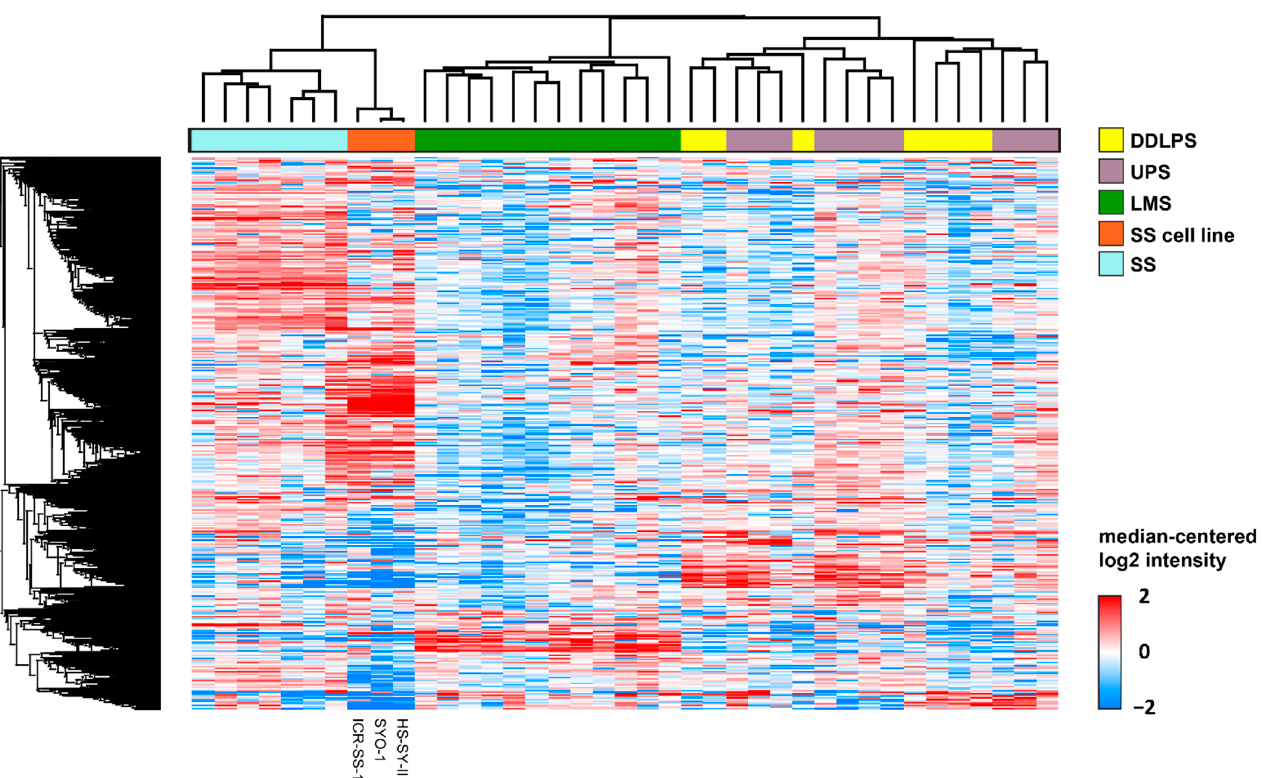
Figure 4. Heatmap displaying hierarchical clustering of proteomic data from synovial sarcoma cell lines and patient specimens of four histological subtypes (dedifferentiated liposarcoma—DDLPS, undifferentiated pleomorphic sarcoma—UPS, leiomyosarcoma—LMS, and synovial sarcoma—SS). Proteomic data were clustered with two-way unsupervised clustering based on Pearson’s correlation coefficient.